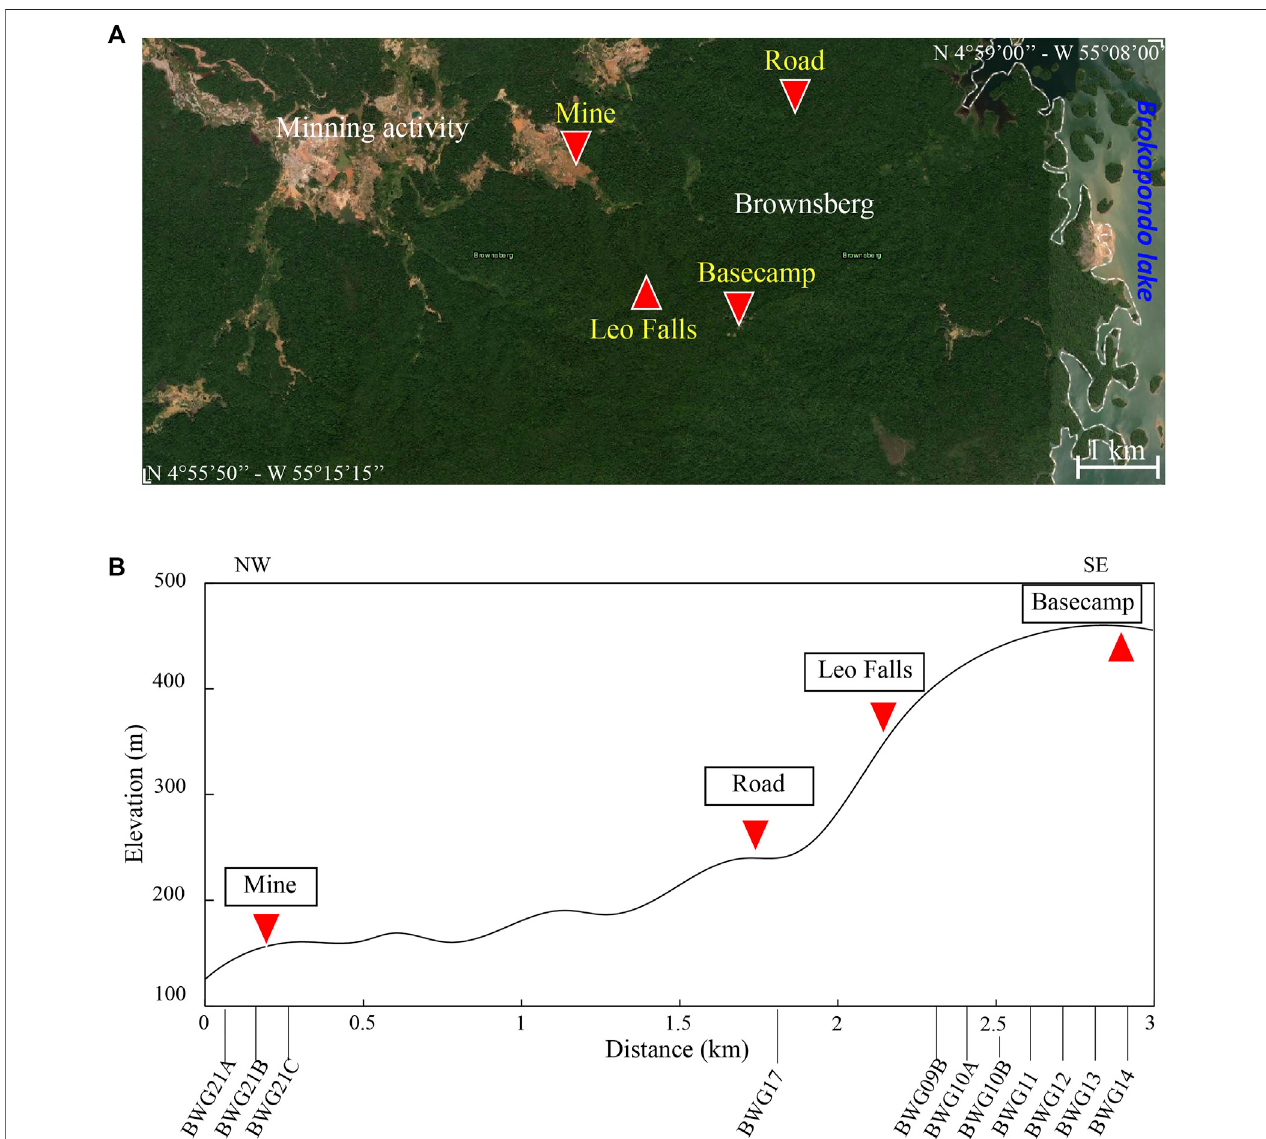
FIGURE 2 | (A) Localization and (B) distance between the valley and the mountaintop, with elevation of the sampling site in the Brownsberg area. Note that the position of the Road site is represented here to visualize its elevation, but it is, in fact, located northeast of the Mine – Leo Falls axis.